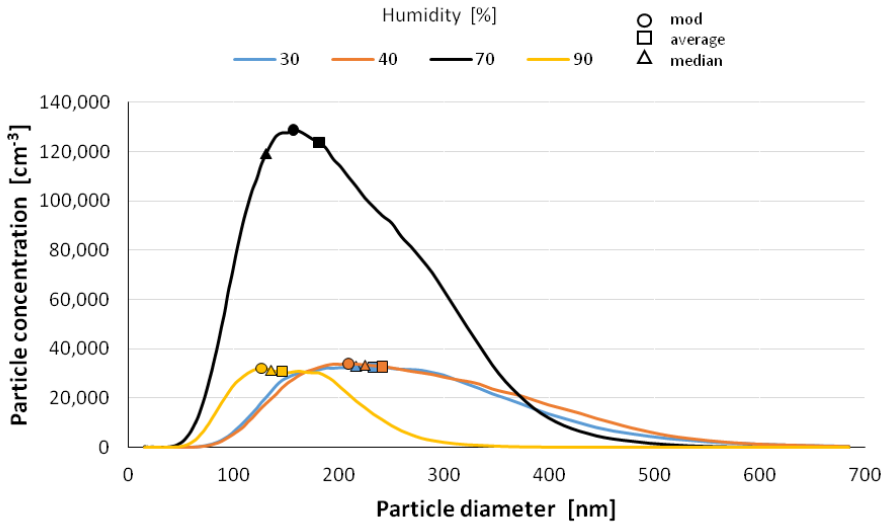
Figure 7. Size distribution of superfine particles 4.5 min after atomization.